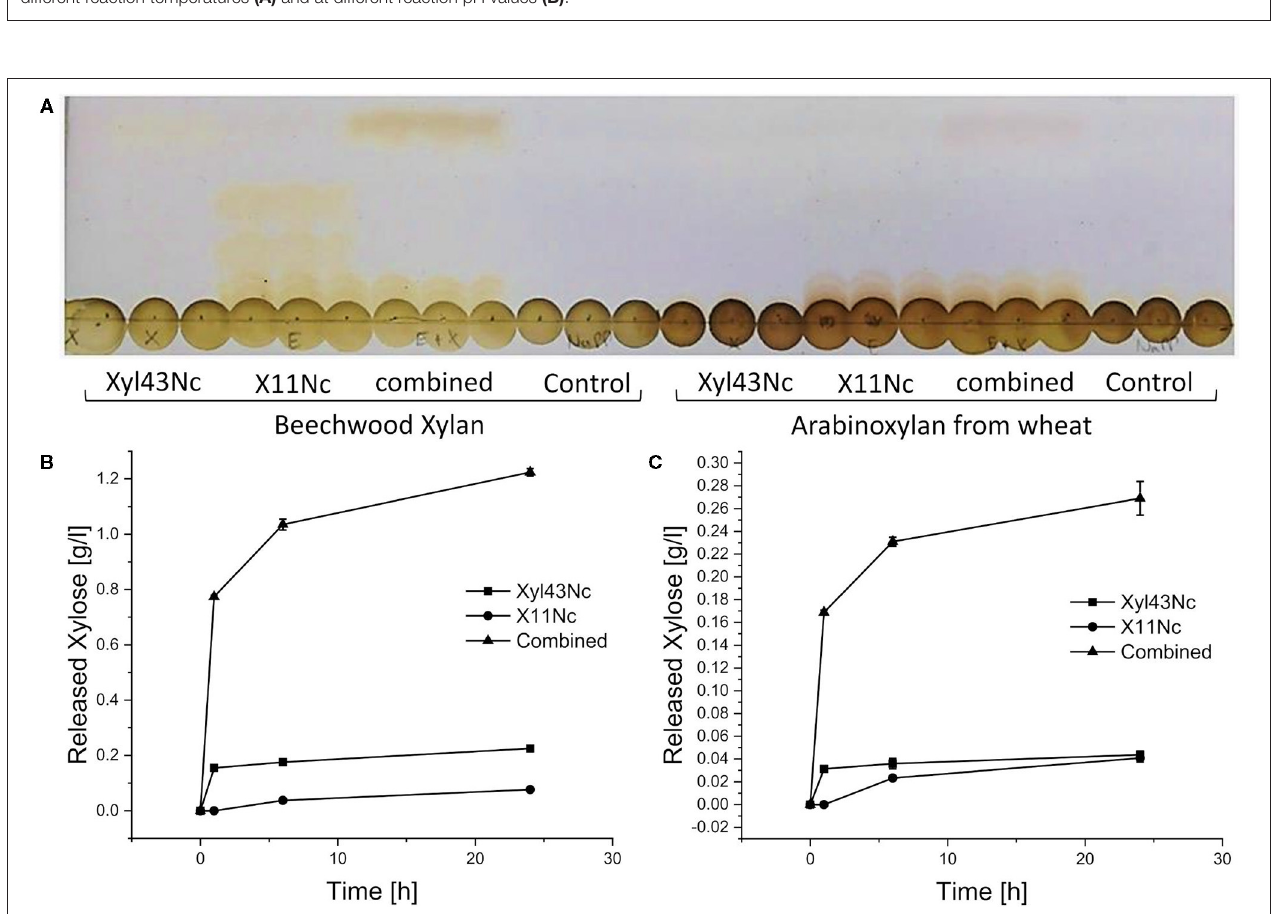
FIGURE 6 | Individual and combined reactions of Xyl43Nc and X11Nc with purified beechwood xylan and arabinoxylan from wheat as substrates. Thin layer chromatography of the triplicate reactions after 24h (A) . Slight bands of xylose can be seen in the reactions of Xyl43Nc alone and much stronger xylose bands in the combined reactions. Concentrations of released xylose during the reactions with purified beechwood xylan (B) and arabinoxylan from wheat (C) .